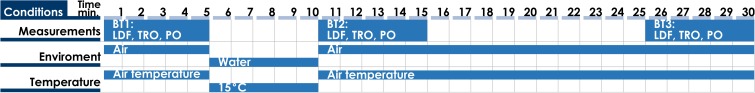
Time chart of the study protocol for the diagnostics of the microcirculatory bed of upper limbs: BT1, BT2, and BT3 – basic tests before, immediately after and 15 min after the cold exposure.